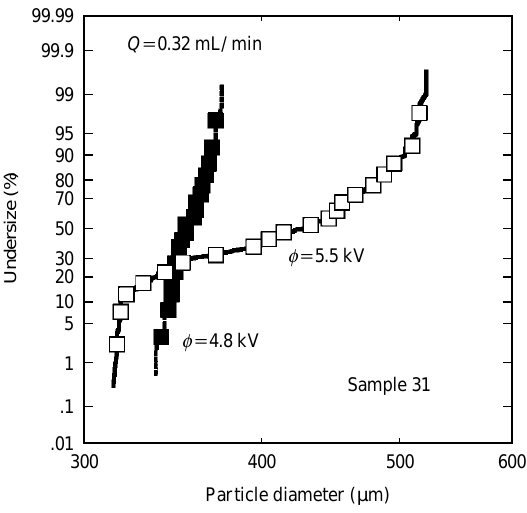
Comparison of Particle Size Distribution in Uniform Cone- jet Mode (4.8 kV) with That in Discharge Mode (5.5 kV)